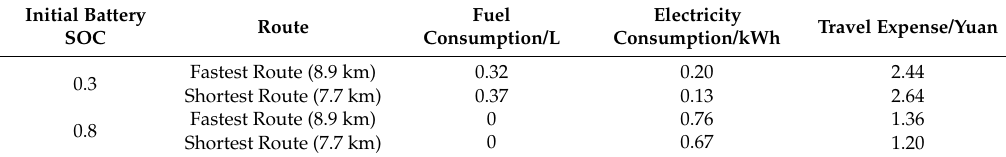
Table 1. Energy consumption of the PHEV.